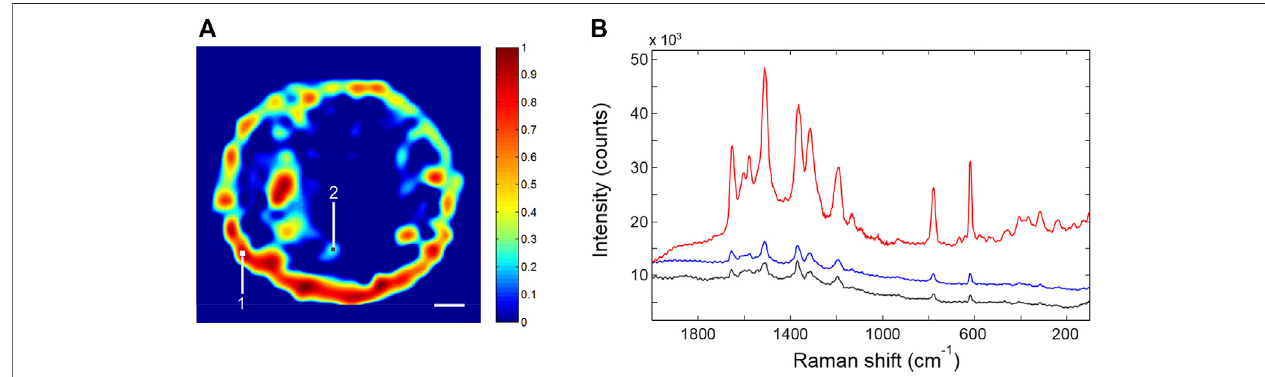
FIGURE 5 | (A) Typical Raman image of the SERS p-jet spot functionalized with R6G. The scale bar corresponds to 20 μ m. (B) SERS spectra collected in points one (red trace) and two (black trace) of the plasmonic surface (locations labeled in Figure 5A ); SERS spectrum averaged over the whole dataset (blue trace).